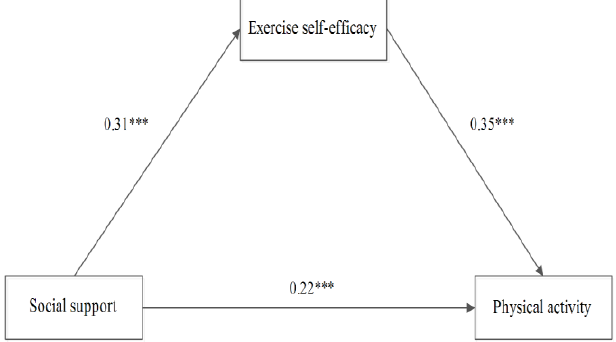
Figure 3. The mediating effect of exercise self-efficacy in girls.